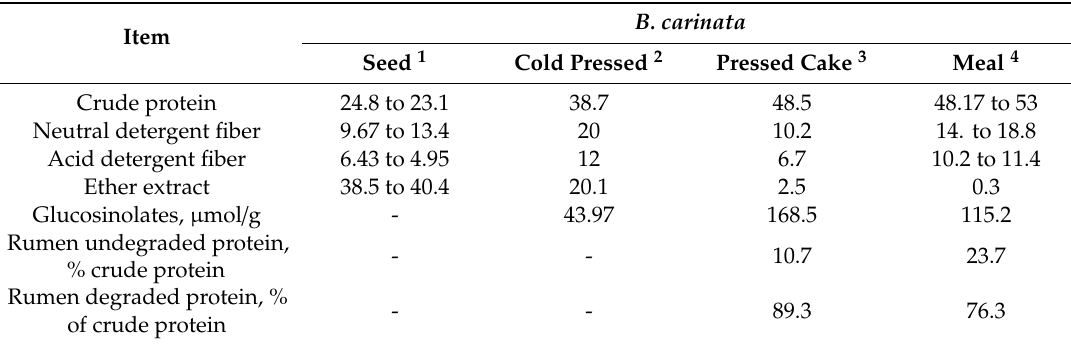
Table 7. Chemical composition of Brassica carinata (% of DM, unless otherwise stated).